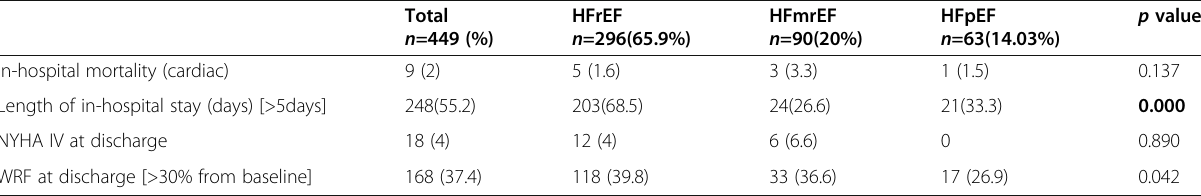
Table 3 In-hospital outcome: based on ejection fraction (univariate analysis)